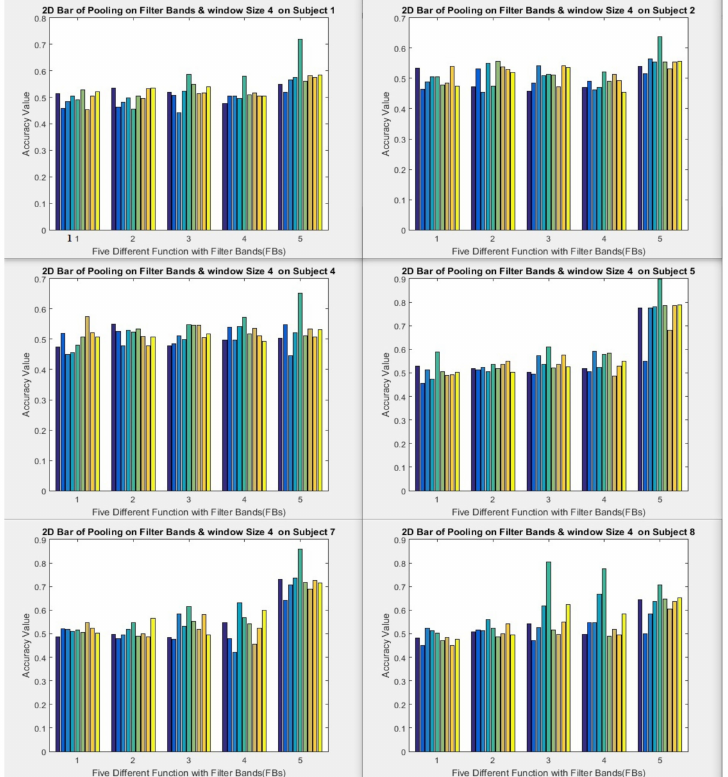
Figure 8. Reduction data based on pooling model on some subjects (1, 2, 4, 5, 7, 8) and filter banks with window size 4 and RF for 10